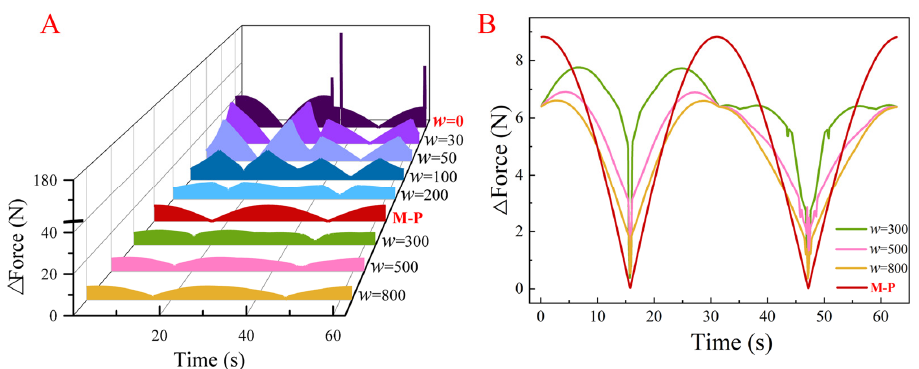
Figure 10. Driving force mutation of MCPM ( M = 1, N = 2) using different optimization methods: ( A ) overall 3D view and ( B ) comparison of the M ‐ P method and improved method in 2D view.